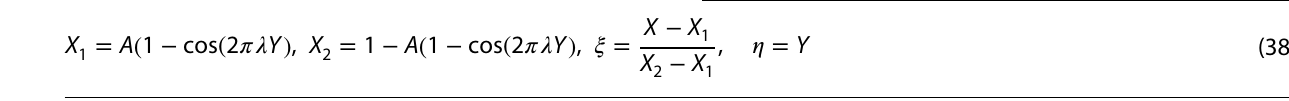
–Cu/water Hybrid Nanofluid at 2